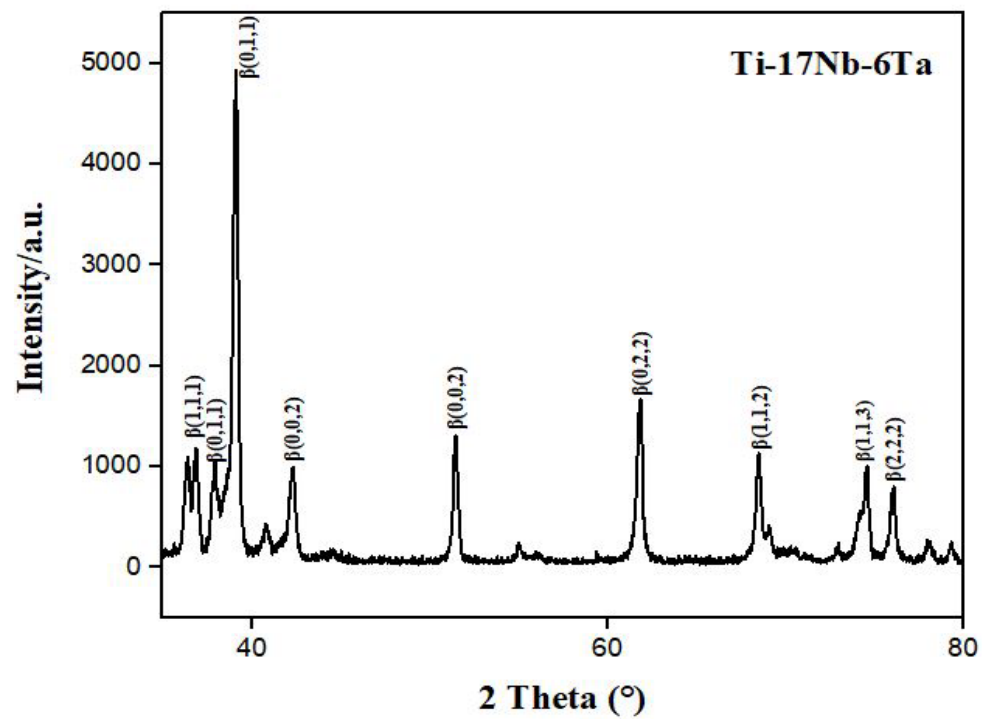
Figure 5. XRD spectrum of the alloy Ti-17Nb-6Ta.